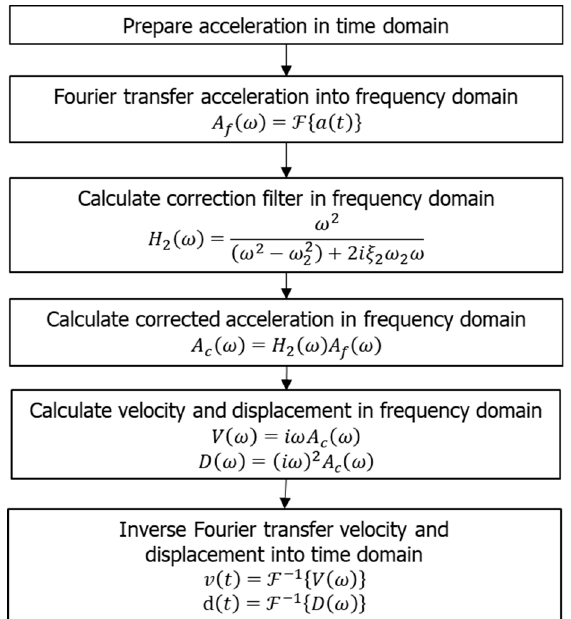
Figure 5. Flowchart for the conversion of acceleration data using Method 1.